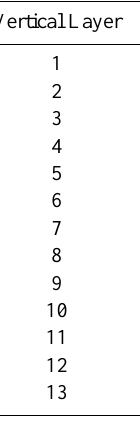
Table 1. Physical descriptions of the four meteorological scenarios used to create the four metamodels.